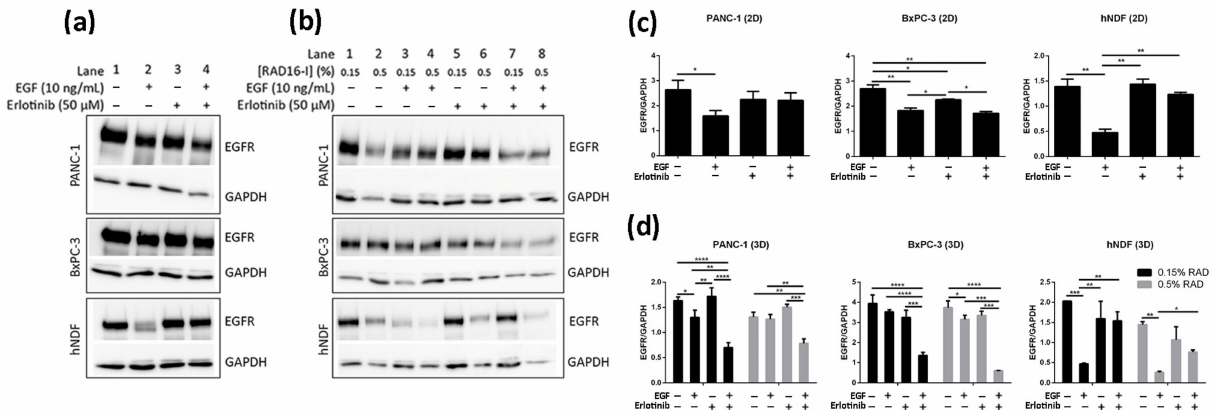
Figure 7. Western blot analysis of the EGFR in BxPC-3, PANC-1 and hNDF cells incubated with EGF or erlotinib or both in 2D cultures and soft and stiff 3D cultures. ( a ) Western blot bands of EGFR in 2D cultures; ( b ) Western blot bands of EGFR in 0.15% and 0.5% RAD16-I 3D cultures; ( c ) densitometry of bands shown in ( a ) for 2D cultures; ( d ) densitometry of bands shown in ( b ) for 3D cultures. GAPDH was used as an internal control. One representative blot is shown. Experiments were repeated three times (N = 3), and statistical differences are indicated as * for p < 0.05, ** for p < 0.01, *** for p < 0.001 and **** for p <